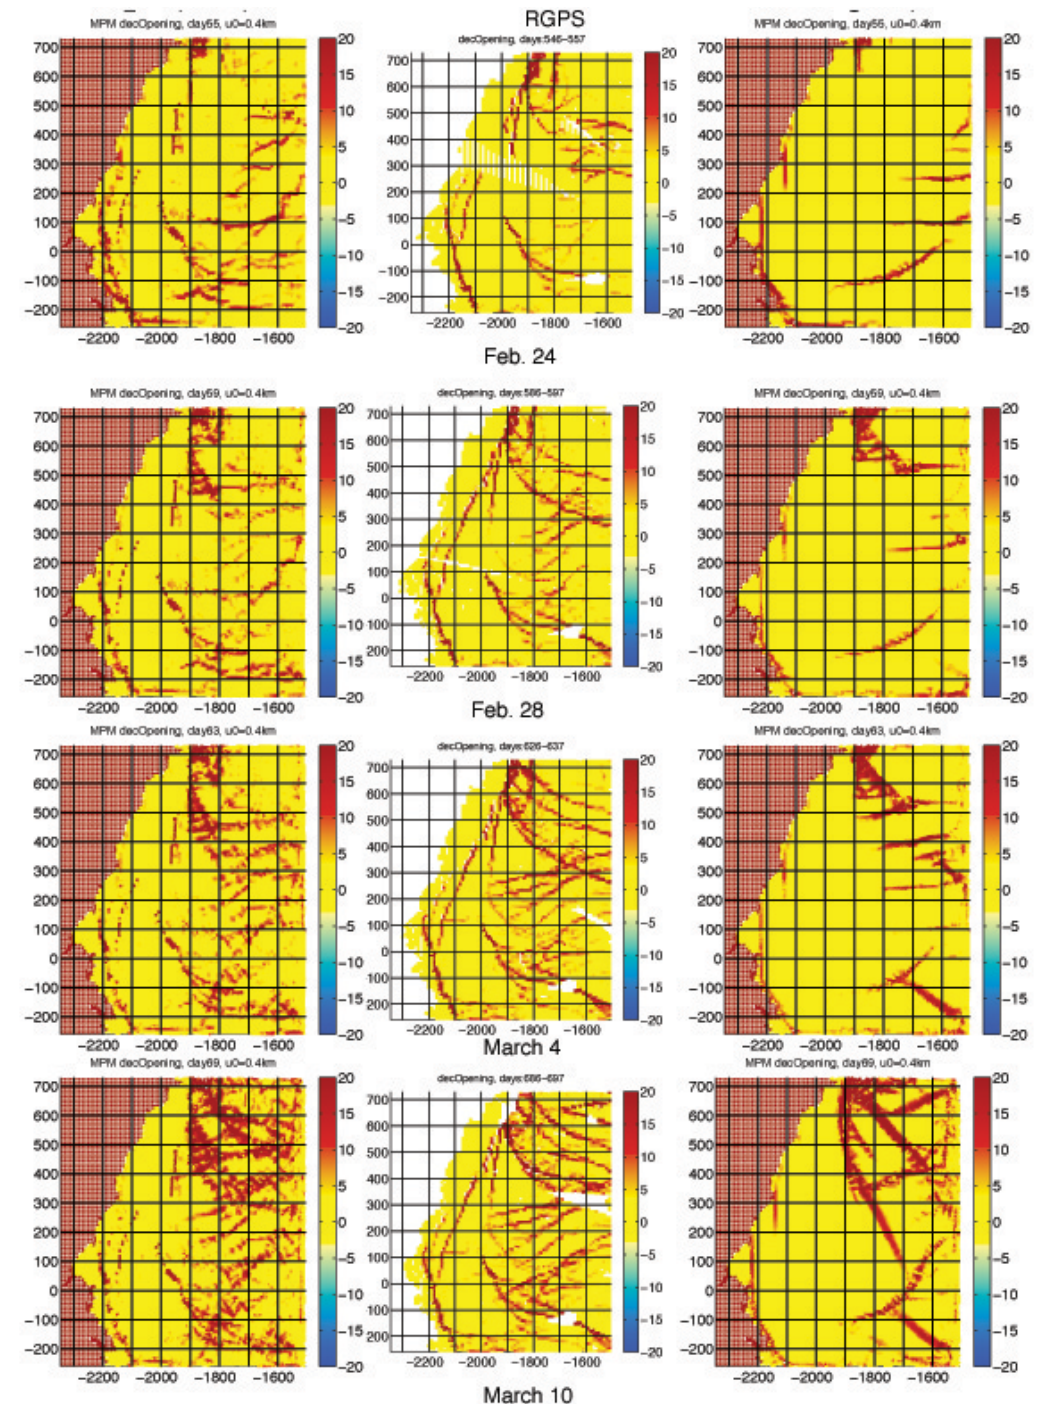
Fig. 3. Comparisons of the experimental (left column) and control (right column) simulations with LKFs interpreted from the RADARSAT Geophysical Processor System (RGPS) data (center column) on (from top to bottom) 25 February 2004 (day 56, first day of positive skill score for experimental run), 28 February (day 59, first day of positive skill score for control run), 4 March (day 63) and 10 March (day 69). The RGPS data were processed assuming that all deformation should be accounted for by shearing, opening and closing of a discontinuity, which passes through the cell center (Coon et al.,